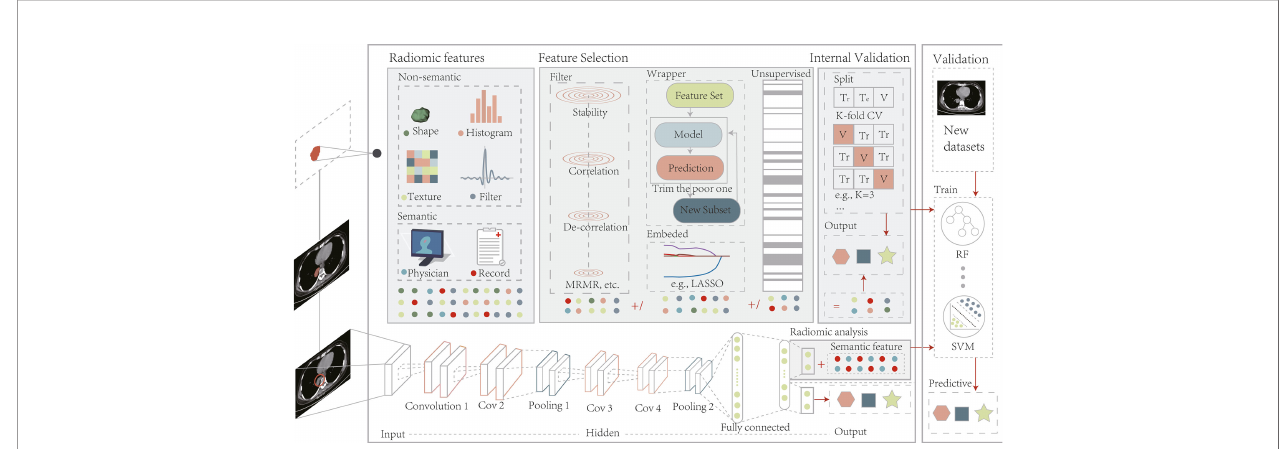
FIGURE 2 | The radiomics pipeline includes two modeling approaches, manually de fi ned and depth features. Modeling pre-de fi ned features involve several basic steps, including image acquisition and pre-processing, ROI segmentation, computation of features, feature fi ltering, and internal validation. Deep learning picks up features by performing end-to-end training on a coarse region containing the target without a separate feature extraction and selection process. After training is complete, depth features can be combined with semantic ones for radiomic analysis or applied directly to model prediction. The models built by both methods should undergo external validation on a new dataset. Tr, Train; Te, Test; V, Validation; LASSO, least absolute shrinkage and selection